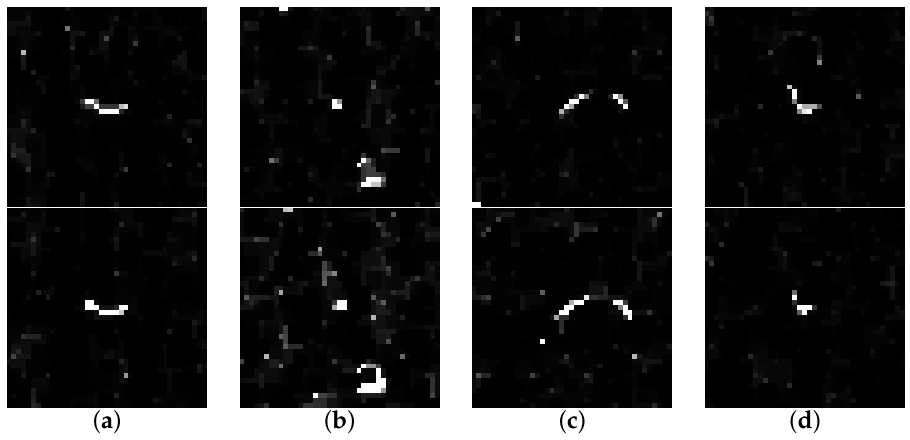
Figure 6. Example matched texture blocks (41 by 41 pixels) of measurement 2 (top) and 3 (bottom).